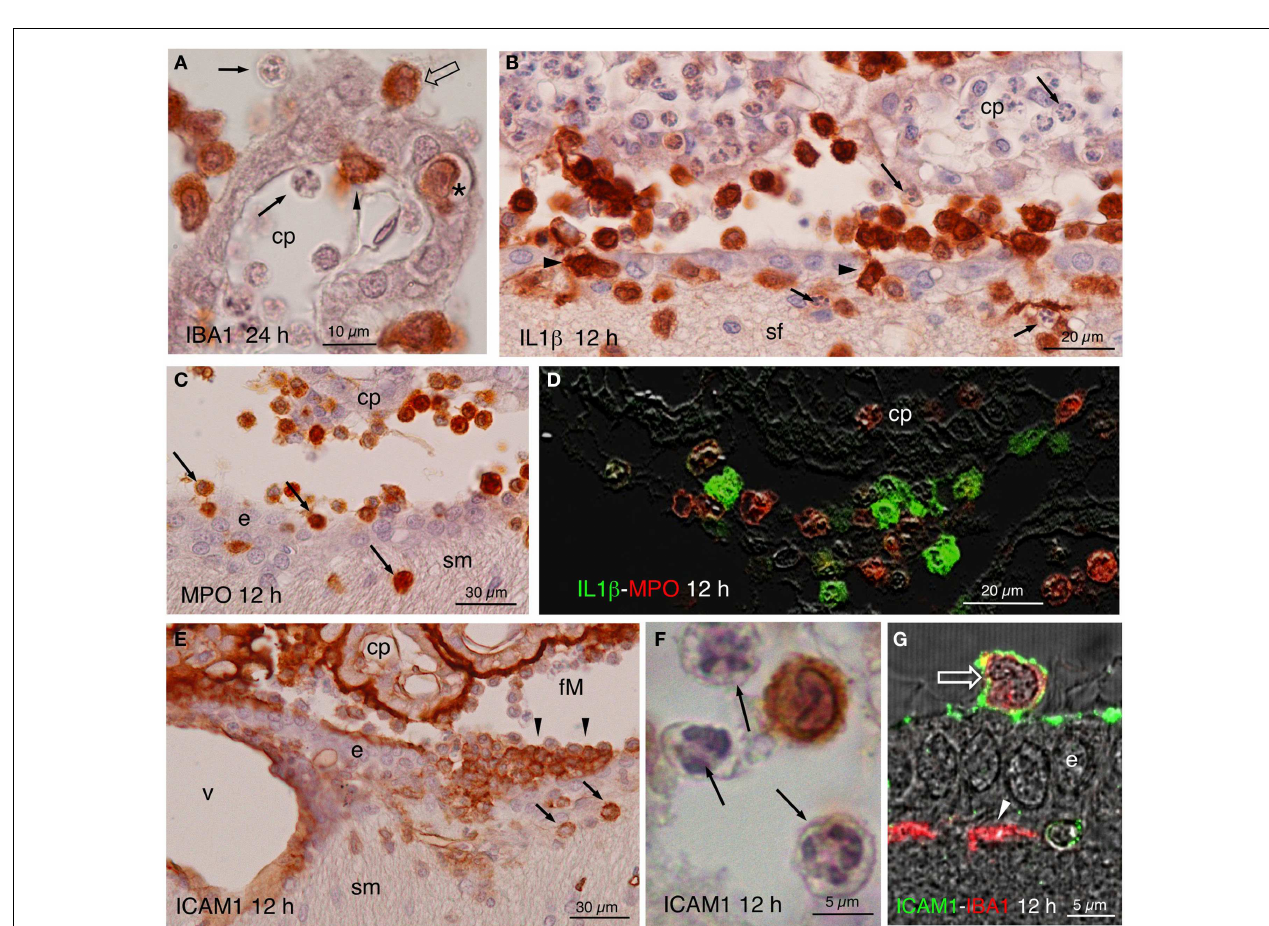
injected ventricle 12h after NA administration. No double-stained cells were detected. (E) Detail of a zone of the foramen of Monro (fM) comprising a part of the stria medullaris (sm) 12h after the injection of NA, immunostained with anti-NCAM1.The surface of the ependymal cells (e) and of the choroid plexus (cp) and the wall of the local vessels (v) was strongly stained. Some infiltrating cells in the ventricle (arrowheads) and in the brain parenchyma (arrows) were also positive. (F) Detail of an immunoreactive cell with lobed nucleus in the ventricle.The polymorphonucleated leukocytes (arrows) were never immunoreactive to ICAM1. (G) Some cells present in the ventricle were double-stained with ICAM1 and IBA1 (open arrow).The ICAM1-positive surface of the ependymal cells (e) can be observed, as well as some IBA1-positive subependymal cells (arrowhead). cp, choroid plexus; sf, septum-fimbria; e, ependyma; sm, stria medullaris; fM, foramen of Monro; v,